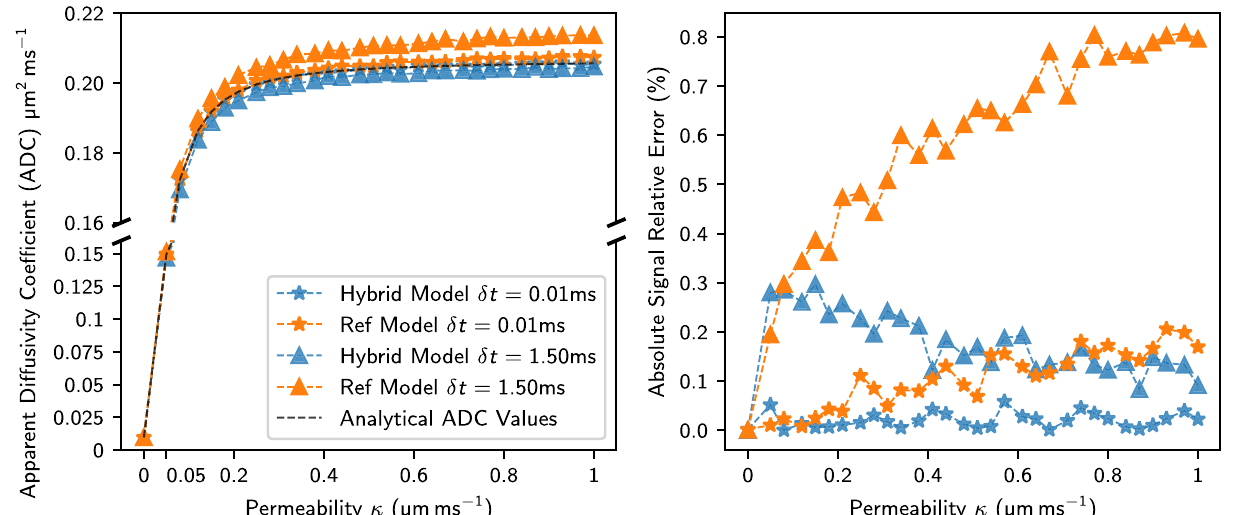
Figure 8. Absolute relative signal error and ADC values for a wide range of permeability values considering 0.01 ms ) and large ( δ t 1.5ms ) time step. All the simulations consider N a very small ( δ t = = 2 µ m 2 / ms and D ICS 0.5 µ m 2 / ms D ECS = =